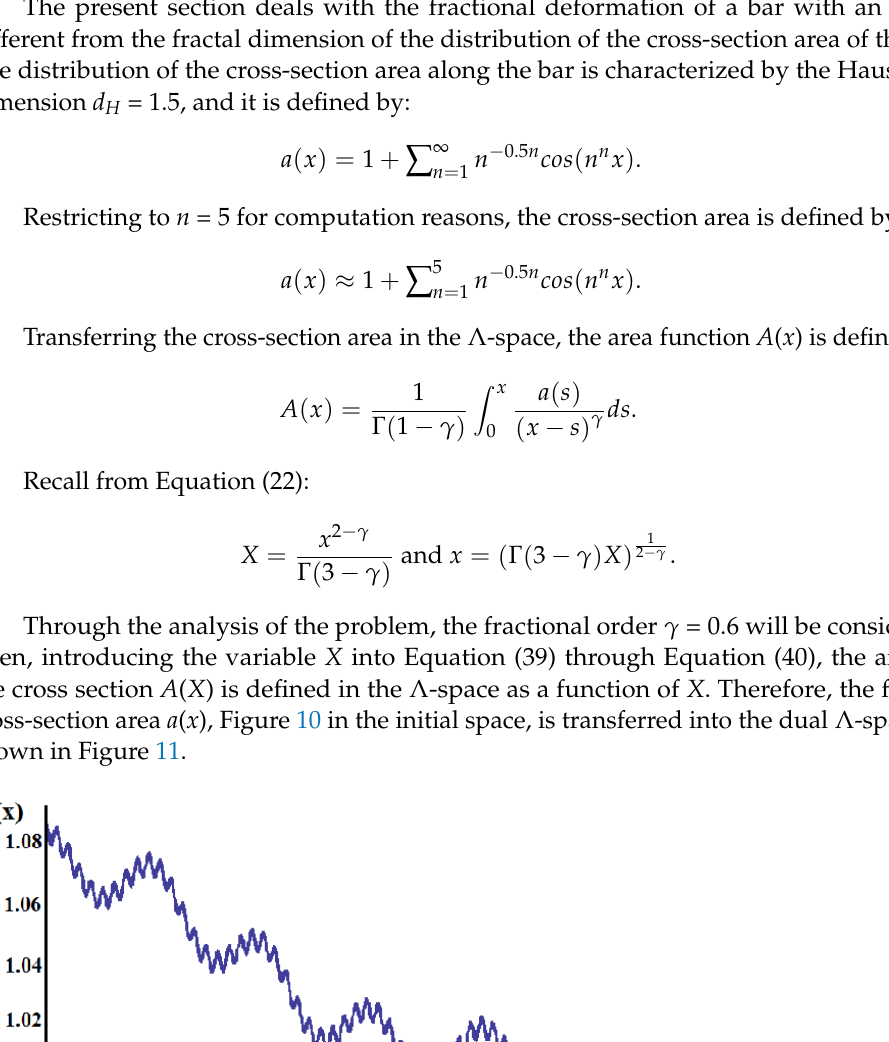
Figure 11. The distribution of the cross-sectional area A ( X ) in the Λ -space.